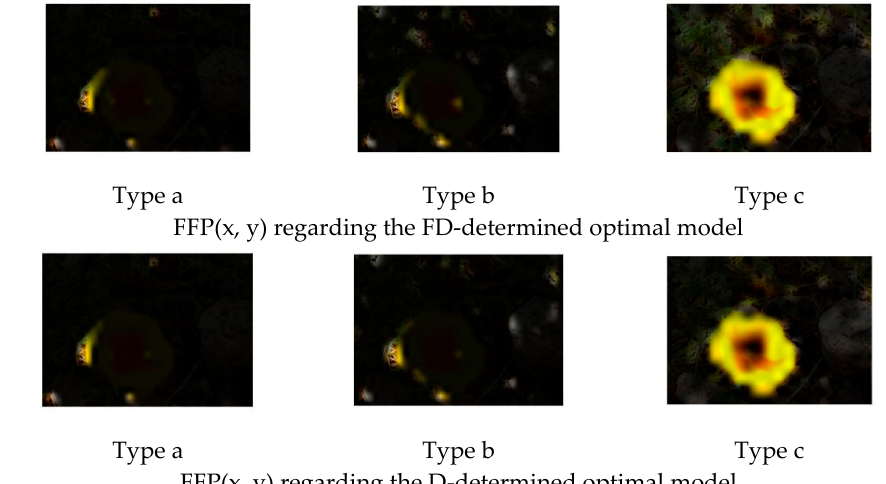
FFP(x, y) regarding the FD-determined optimal model